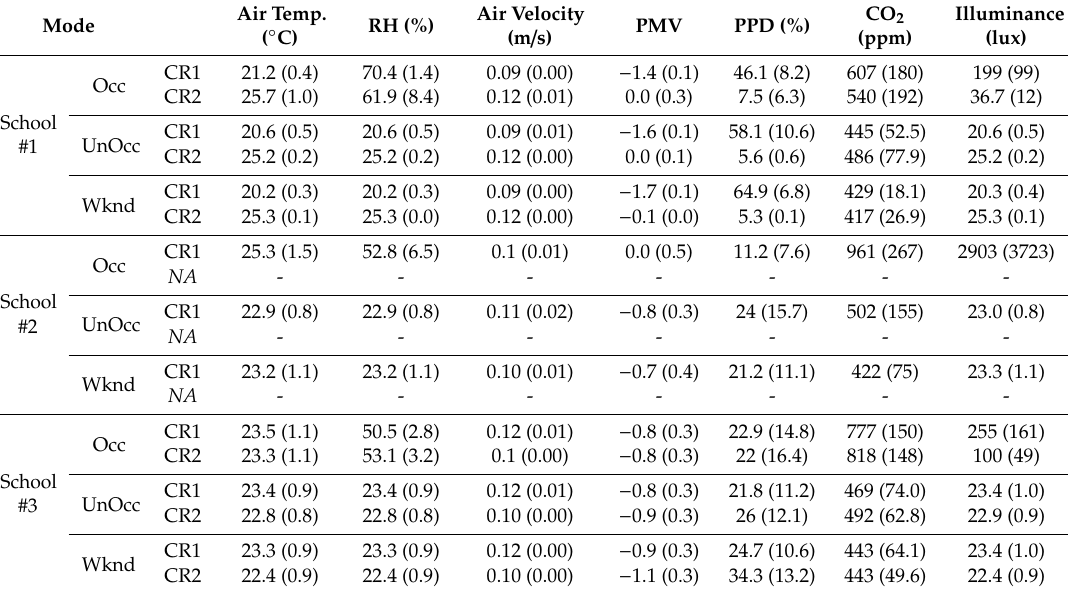
Table 6. Mean (Standard Deviation) of the Measured IEQ Variables by Occupancy Mode.